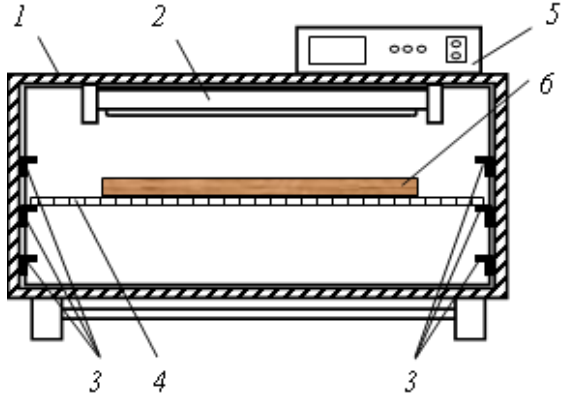
Figure 2. Diagram of an experimental setup for ultraviolet irradiation of materials. To reflect ultraviolet rays, the inner wall of the chamber 1 has a mirror